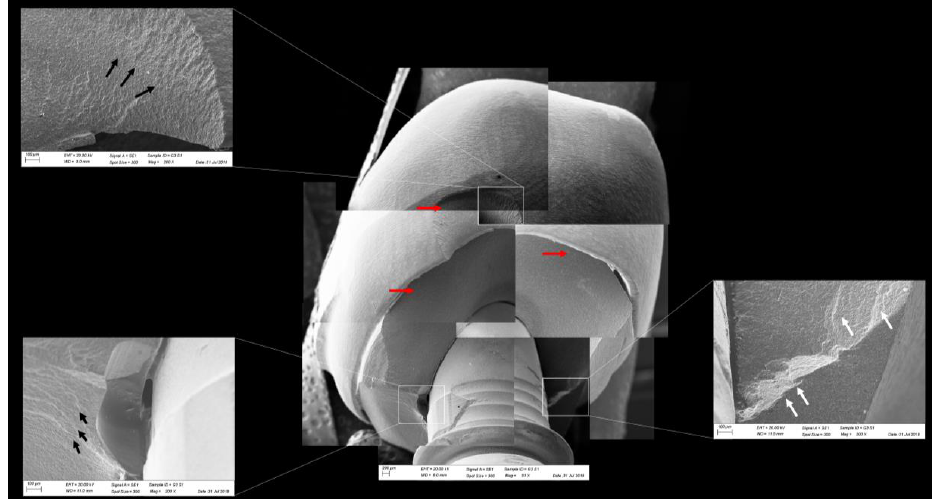
Figure 12. Fractographic analysis of a representative specimen from the CME group. The mesostructure failed without the involvement of the crown. The black arrows indicate the hackle lines, the white arrows indicate the arrest lines, and the red arrows indicate compression curls.